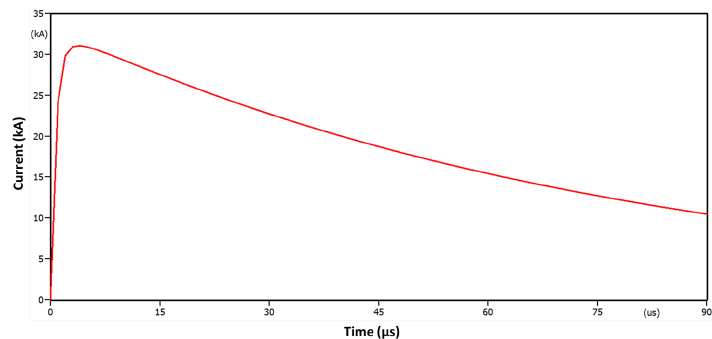
Figure 5. Heidler’s current impulse with parameters 3.83/77.5 µ s and 31.1